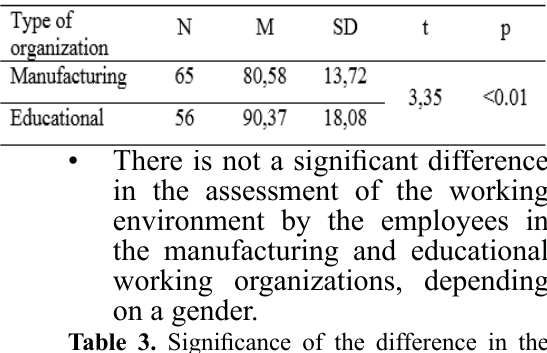
Table 2. Significance of the difference in the personal sense for communication between the employ - ees in the manufacturing and educational working organizations